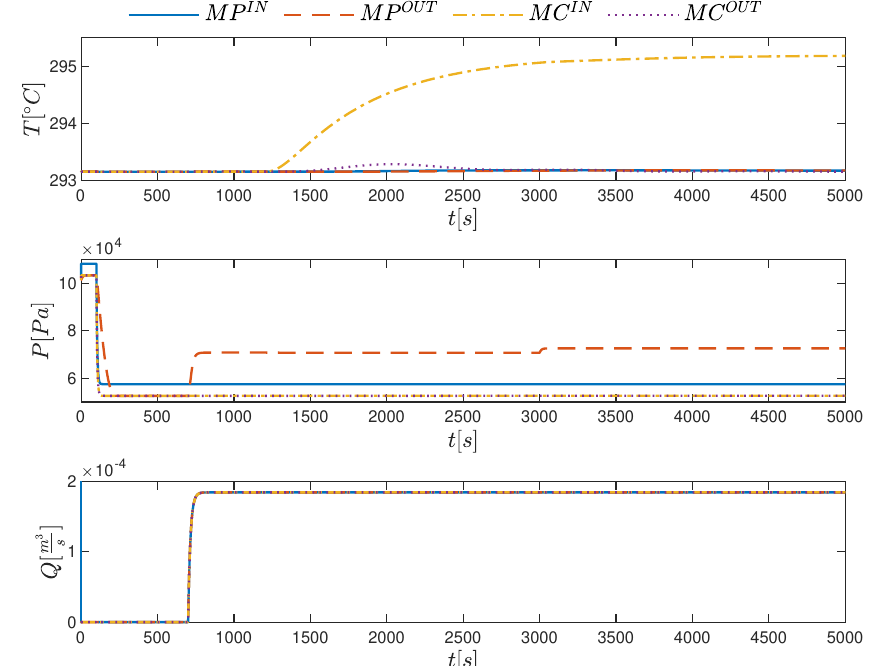
Figure 20. Temperature, pressure and volumetric flow change in the system during the simulation scenario. Measurements have been taken before pump ( MP IN ), after pump ( MP OUT ), before the chiller ( MC IN ) and after the chiller ( MC OUT ).